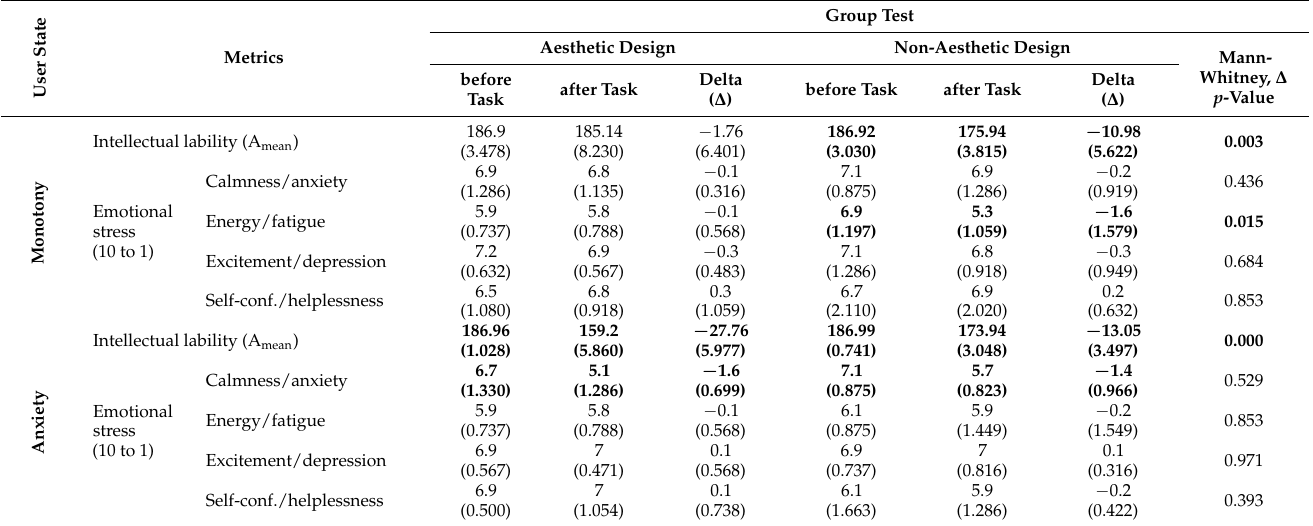
Table 4. The results of the experiment, group testing, aesthetic vs. non-aesthetic